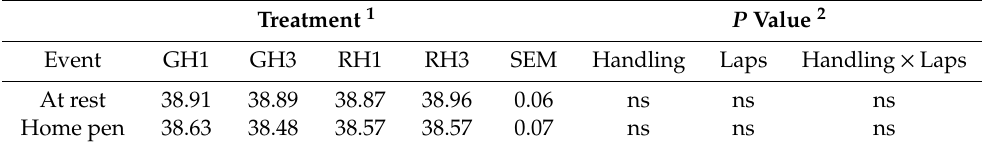
Table 5. Least square means of rectal temperature by treatment and